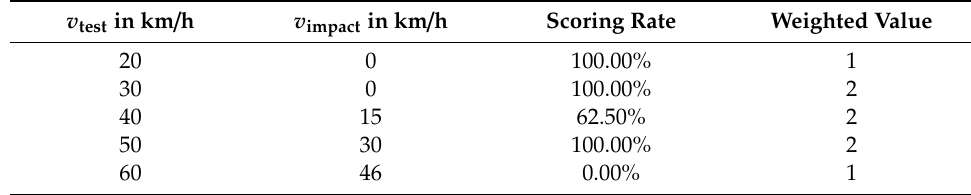
Table 7. The test results at each test velocity in CVFA-50